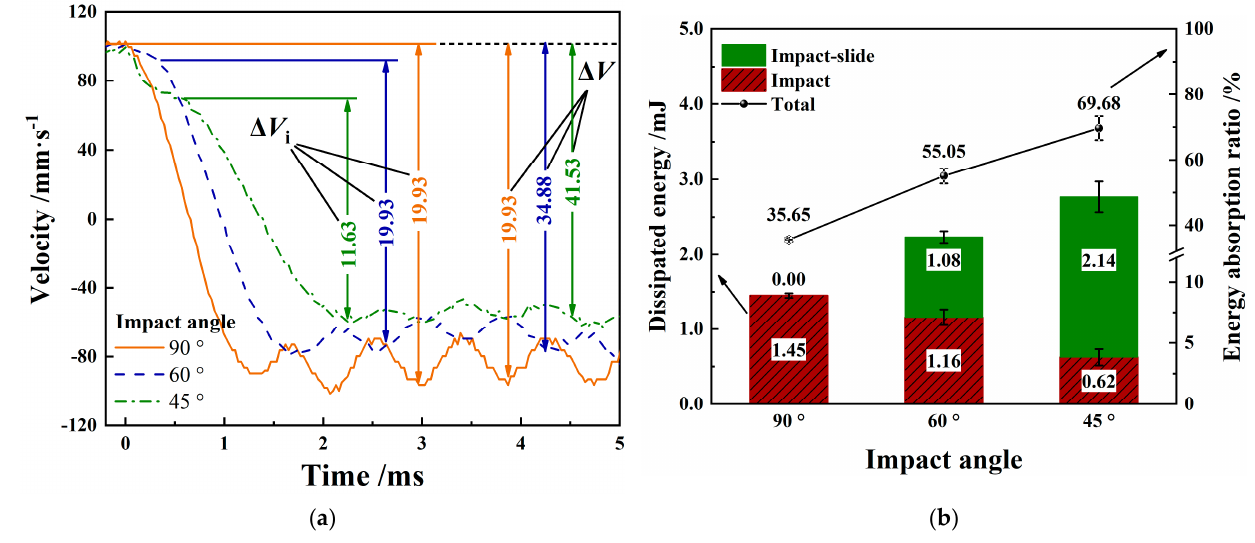
Figure 9. Energy response with varying impact angle. ( a ) Energy response vs. time; ( b ) dissipated energy evolution.